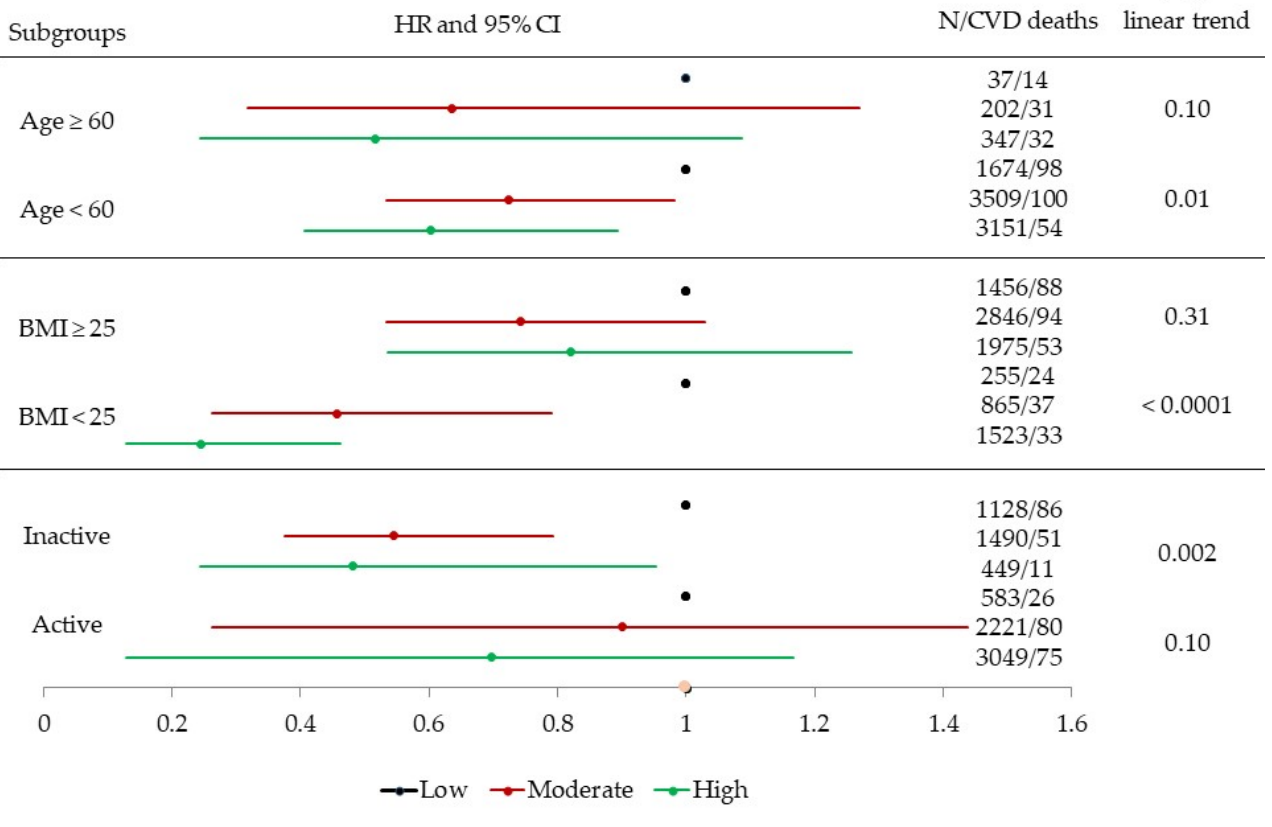
Figure 1. Multivariable-adjusted hazard ratios (HRs) and 95% confidence intervals (CIs) of cardiovascular disease (CVD) mortality across fitness (low, moderate, and high) and age (< 60 and ≥ 60), body mass index (BMI, 18.5–25 and ≥ 25), and physical activity (inactive and active) groups. Adjusted according to baseline age, examination year, total cholesterol, current smoking (yes or no), heavy alcohol intake (yes or no), physically inactive (yes or no), BMI (kg/m 2 ), parental history of CVD, and presence or absence of hypertension or diabetes.